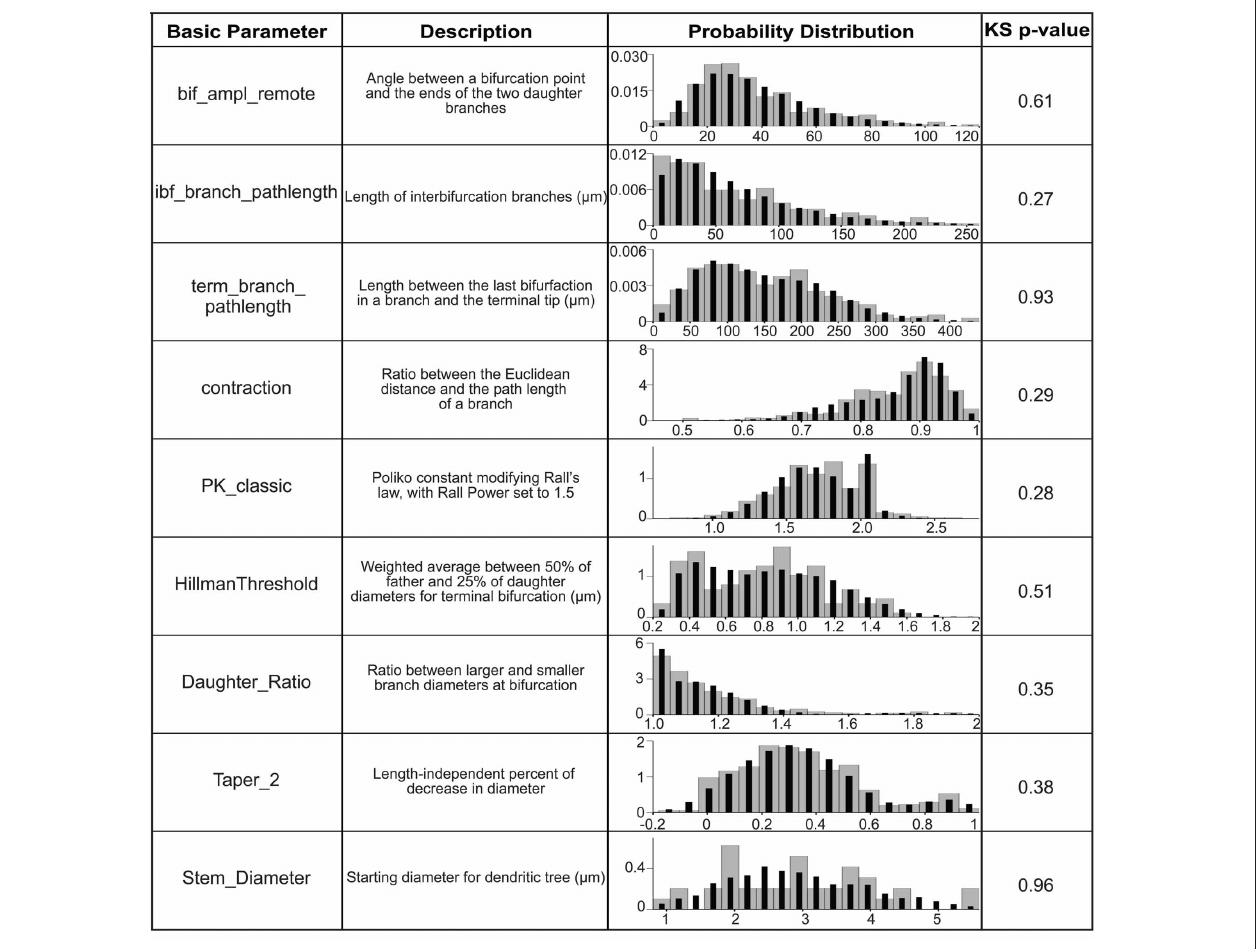
FIGURE 3 | Basic parameter distributions are matched in order to generate virtual granule cells. The basic parameters extracted from L-Measure and incorporated into L-Neuron are listed with their definitions. For more information see the L-Measure website listed in Materials and Methods.